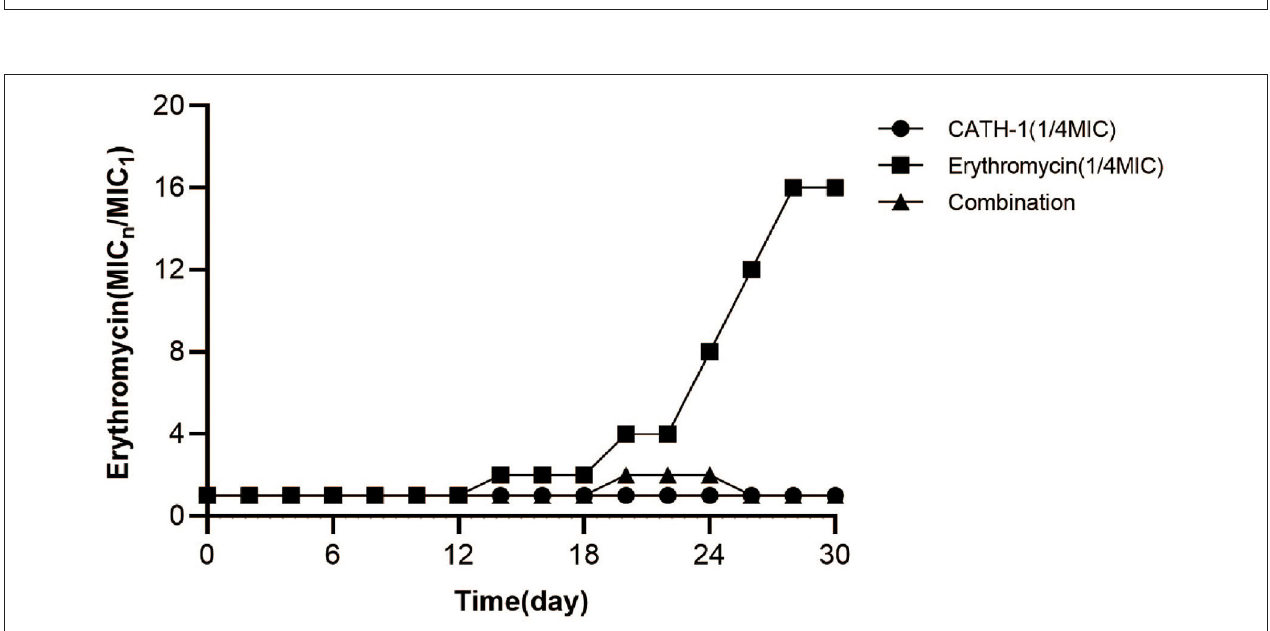
FIGURE 6 | The effect of CATH-1 and erythromycin combination on bacterial drug resistance. The E. coli strain grown independently with CATH-1 (1/4 MIC), erythromycin (1/4 MIC), and CATH-1 (1/8 MIC) combination with erythromycin (1/16 MIC) at 37 ◦ C for consecutive 30 generations. A fixed concentration of CATH-1 (equivalent to 1/4 MIC) was added to the 2-fold increasing concentration of erythromycin. Bacteria from the highest concentration of drug combination were regrown, and MIC of erythromycin was measured, and then treated them with the drug combination again. The change in MIC was described by normalizing the MIC of n generation to the MIC of first